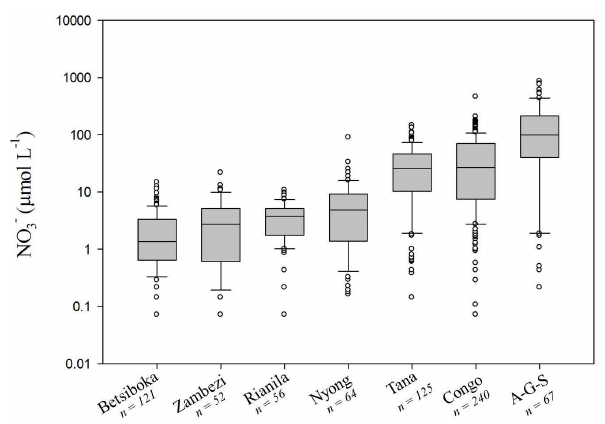
Fig. 9. Box plot of NO − range for seven African river catchments. 3 From left to right: Betsiboka catchment, Madagascar (own unpub- lished data); Zambezi catchment (own unpublished data); Rianila catchment, Madagascar (own unpublished data); Nyong catchment, Cameroon (Viers et al., 2000); Tana catchment, Kenya (Bouillon et al., 2009, and own unpublished data); Congo catchment (ORE- HYBAM and own unpublished data); and the Athi–Galana–Sabaki catchment, Kenya (data presented here). Further data sets included in text.